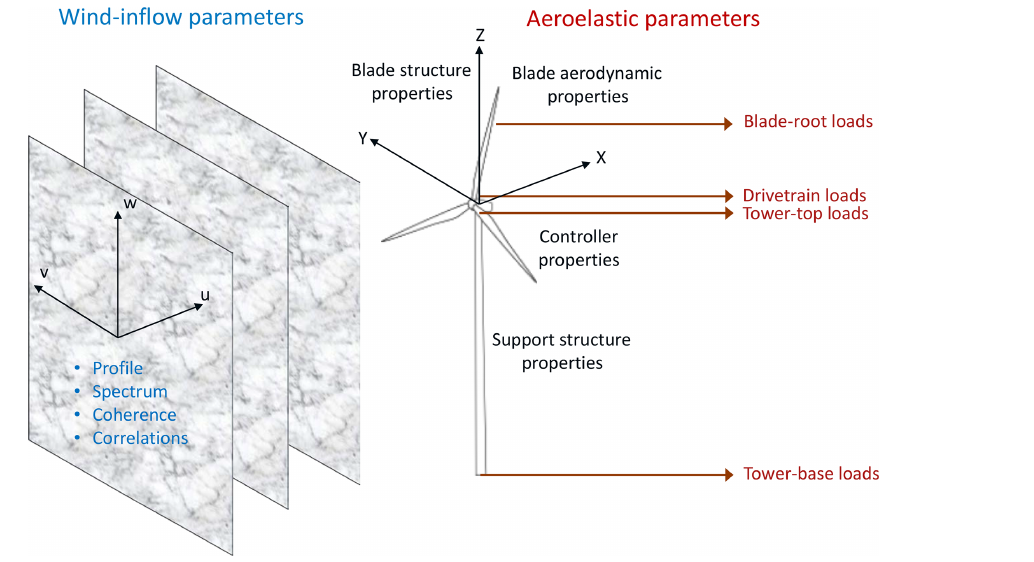
Figure 1. Overview of the parametric uncertainty in a wind turbine load analysis. Includes wind-inflow conditions (subset shown in blue), turbine aeroelastic properties (subset shown in black), and the associated load quantities of interest (QoIs) (subset shown in red).